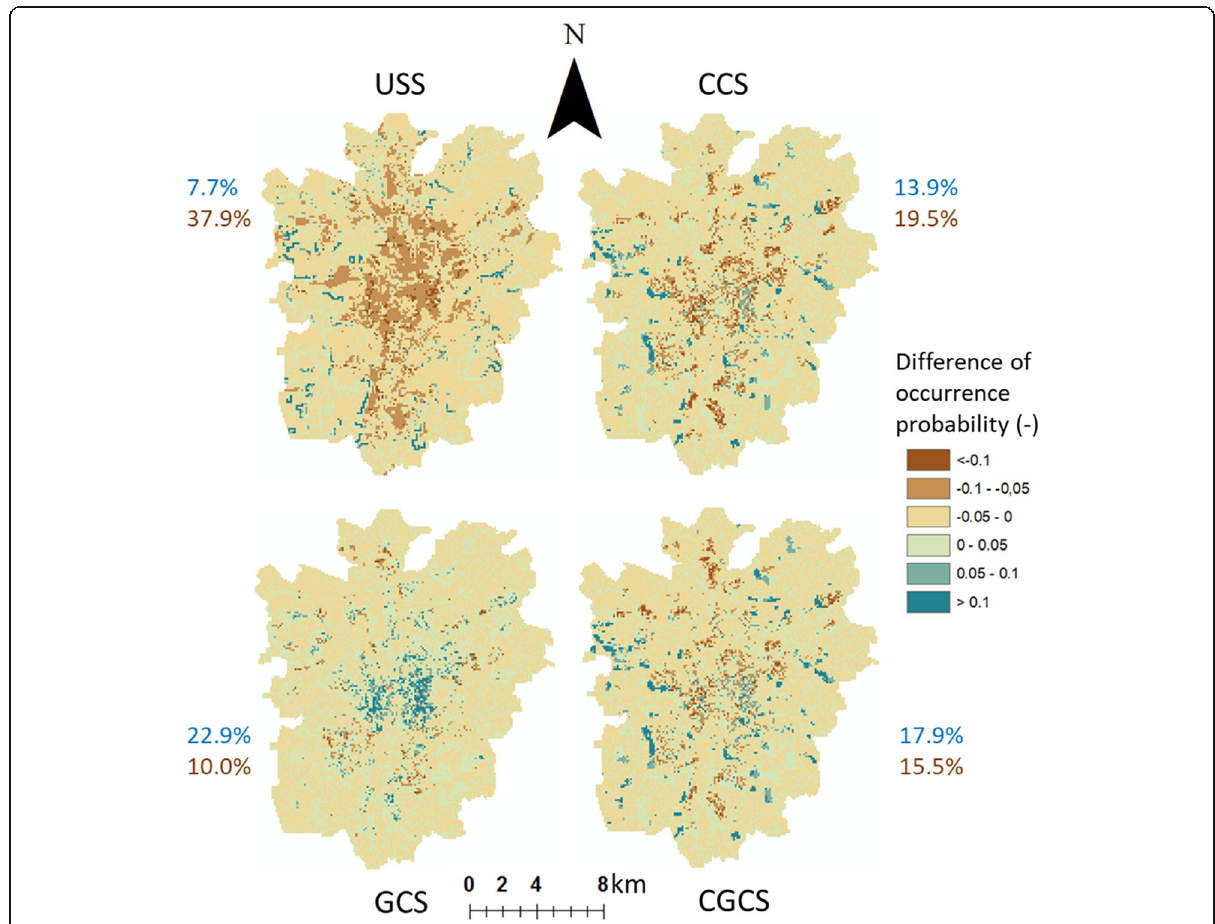
Fig. 4 Average differences of cold-air path occurrence probabilities in the scenarios in comparison to the reference case (= Scenario – REF). The differences were averaged for the 10 steps of land-use modification. Brown colors indicate a reduced probability whereas blue colors indicate an increased probability. The fraction of the study area with increased (blue) or reduced (brown) cold-air path occurrence probabilities is quantified (USS: Urban Sprawl Scenario, CCS: Compact City Scenario, GCS: Green City Scenario, CGCS: Compact Green City Scenario)